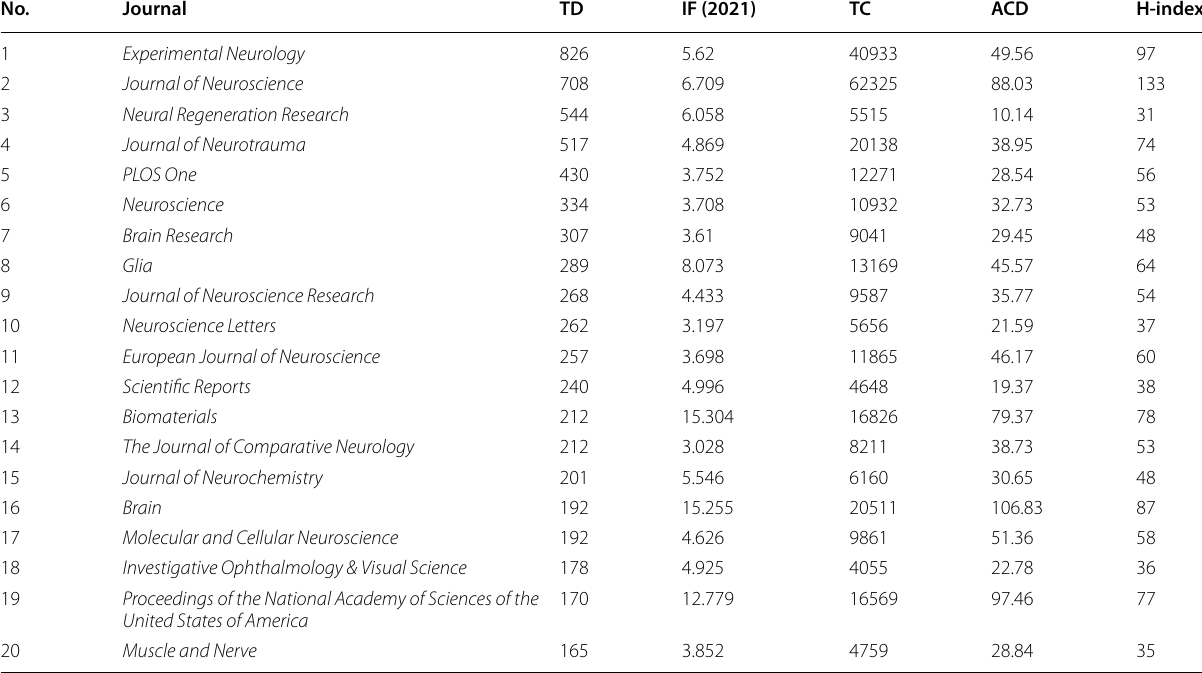
TD the total number of documents, IF impact factor, TC total number of citations, ACD average number of citations per document